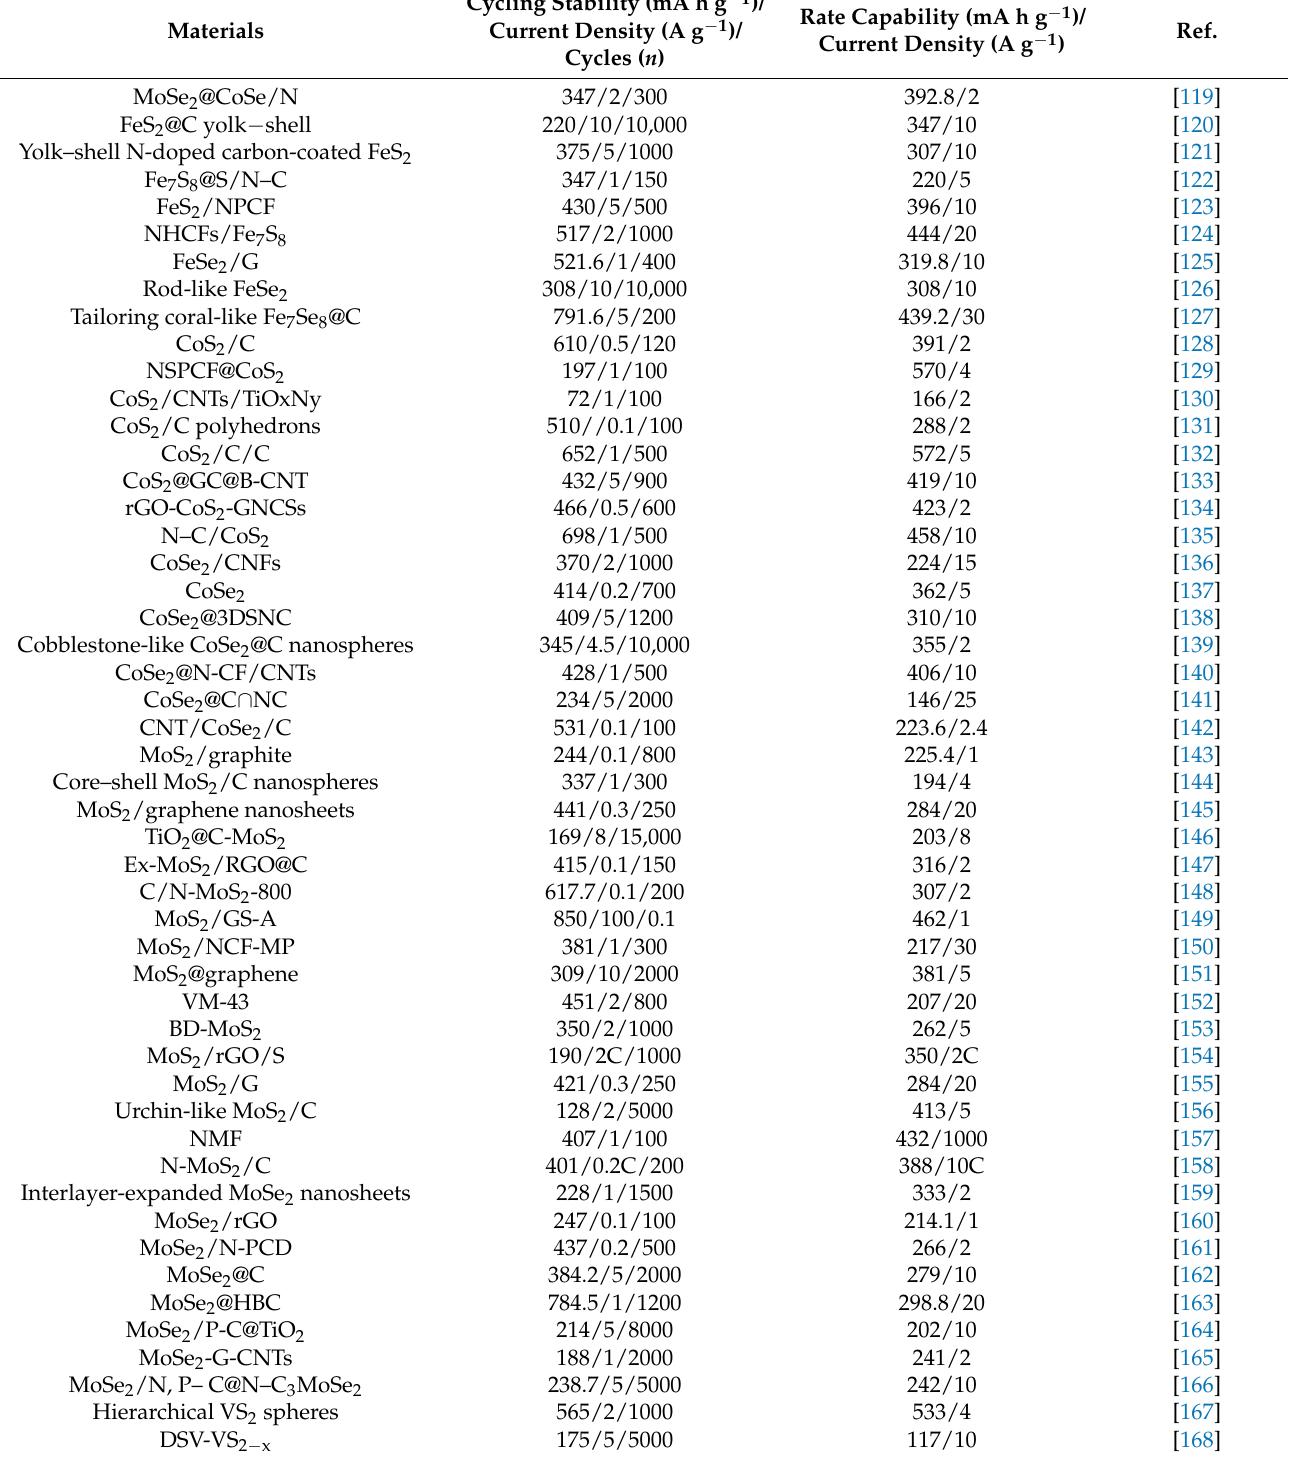
Table 1. The electrochemical performances of representative metal chalcogenides for